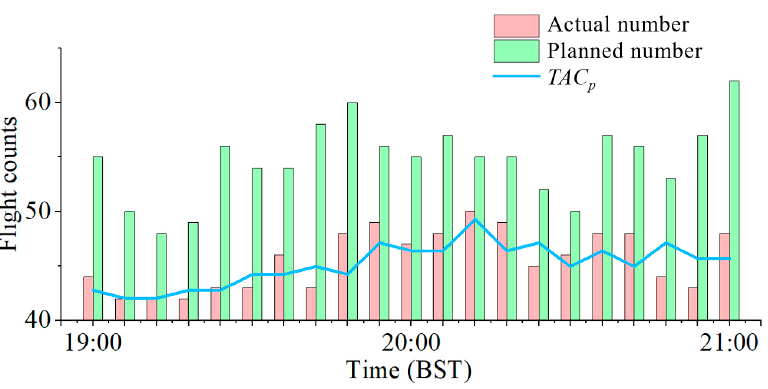
Figure 12. Guangzhou Terminal Area 14 August 2018, 19:00 21:00 TAC p , TAC r and planned number.